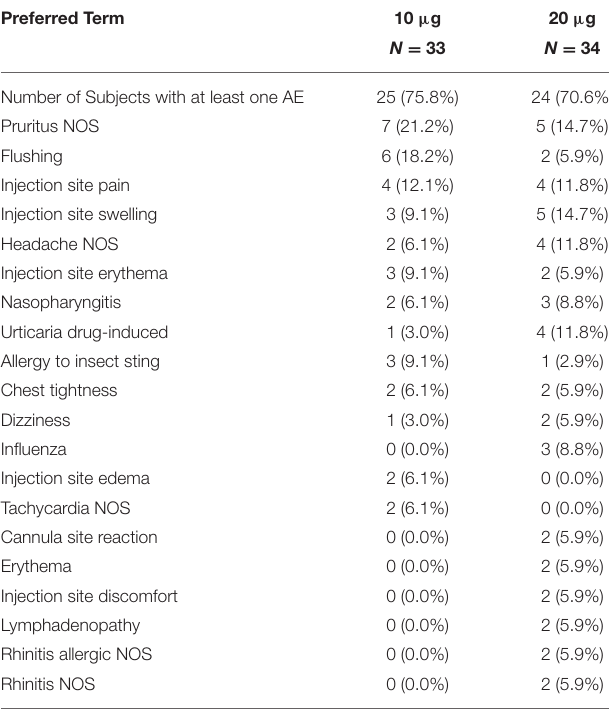
TABLE 1 | Baseline characteristics and demographics for study subjects included in a randomized multicentric bee venom intralymphatic immunotherapy (ILIT) trial. Characteristics